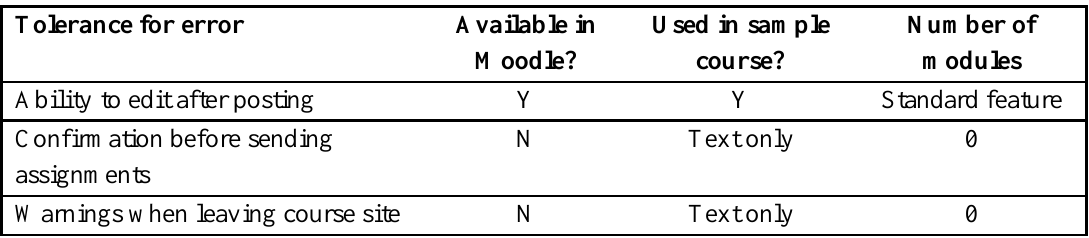
Used in sample Number of Moodle? course? modules N Text only